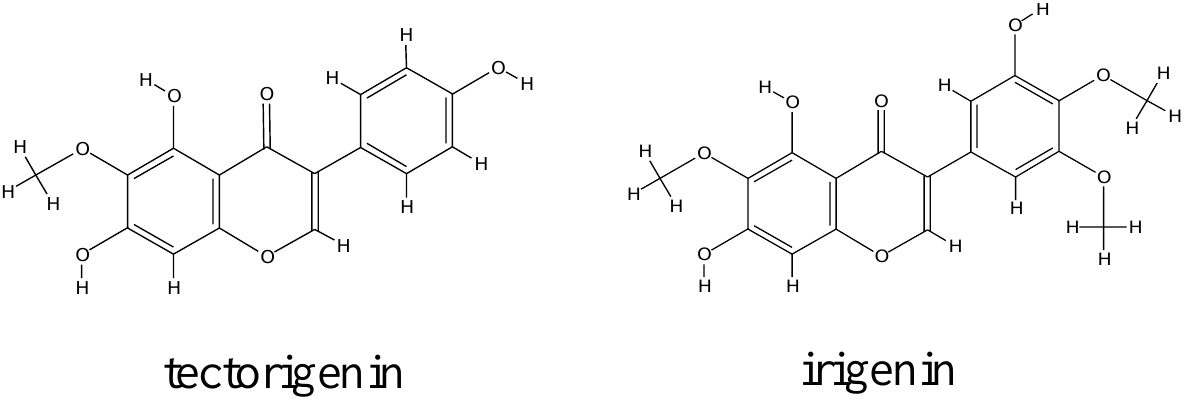
Figure 1. Structures of tectorigenin and irigenin.